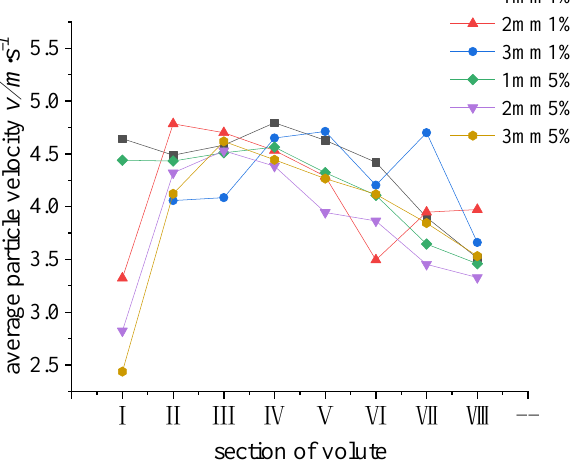
Figure 8. Particle concentration distribution with different valves of particle diameter and concentration.